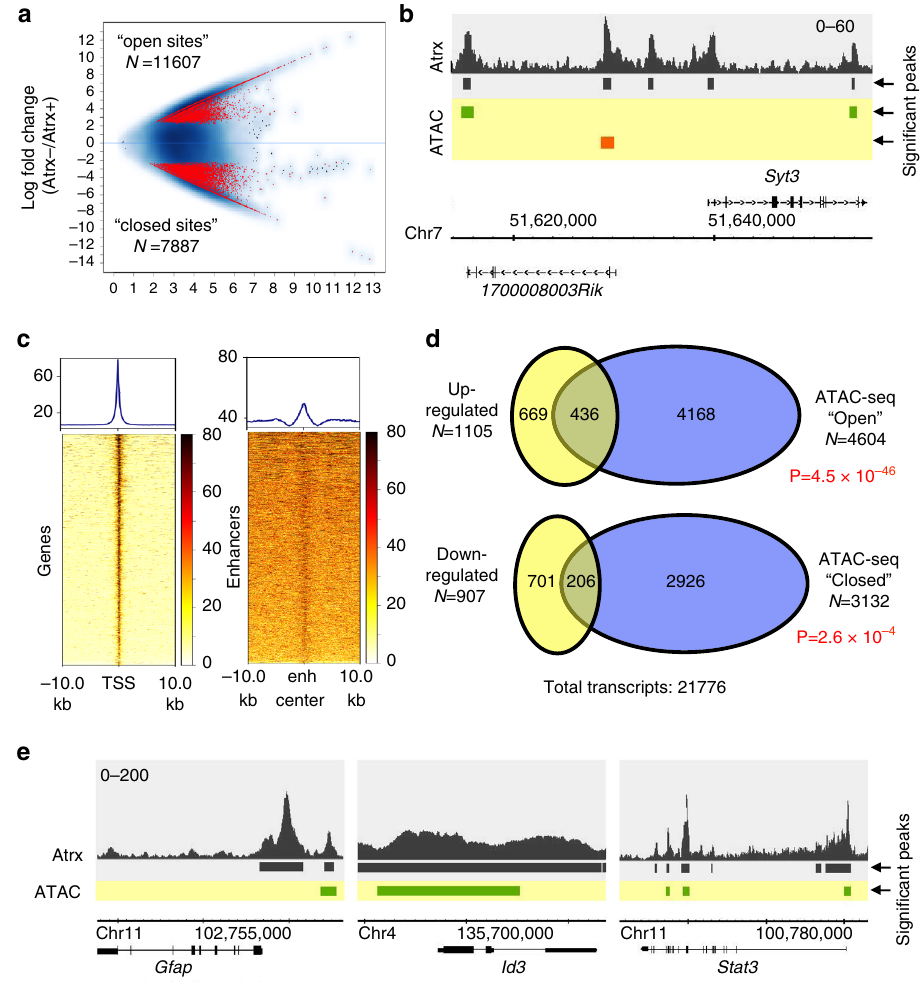
Fig. 5 Atrx de fi ciency alters chromatin accessibility genome-wide at vacant Atrx binding sites. a Volcano plot showing differentially accessible genomic sites (open or closed) arising with Atrx de fi ciency in mNPCs. b Sample trace showing the extent of overlap between Atrx ChIP-seq peaks (black) and ATAC-seq open (green) and closed (red) regions. c heat maps showing the spatial relationships between TSSs, enhancers (enh center), and differentially accessible regions arising in the context of Atrx de fi ciency. d Venn diagrams demonstrating signi fi cant overlaps between upregulated genes and genes approximating ATAC-open sites, and downregulated genes and genes approximating ATAC-closed sites (±10 kb; P values determined by hypergeometric test). e sample traces of astrocytic lineage markers or regulators showing their genomic associations with Atrx binding sites (black) and ATAC-seq open regions